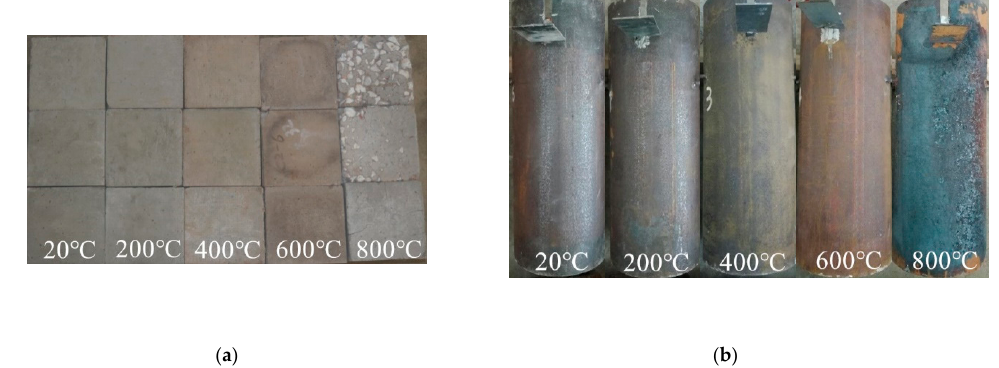
Figure 5. Appearance of specimens after water-cooling. ( a ) high strength concrete test blocks; ( b )